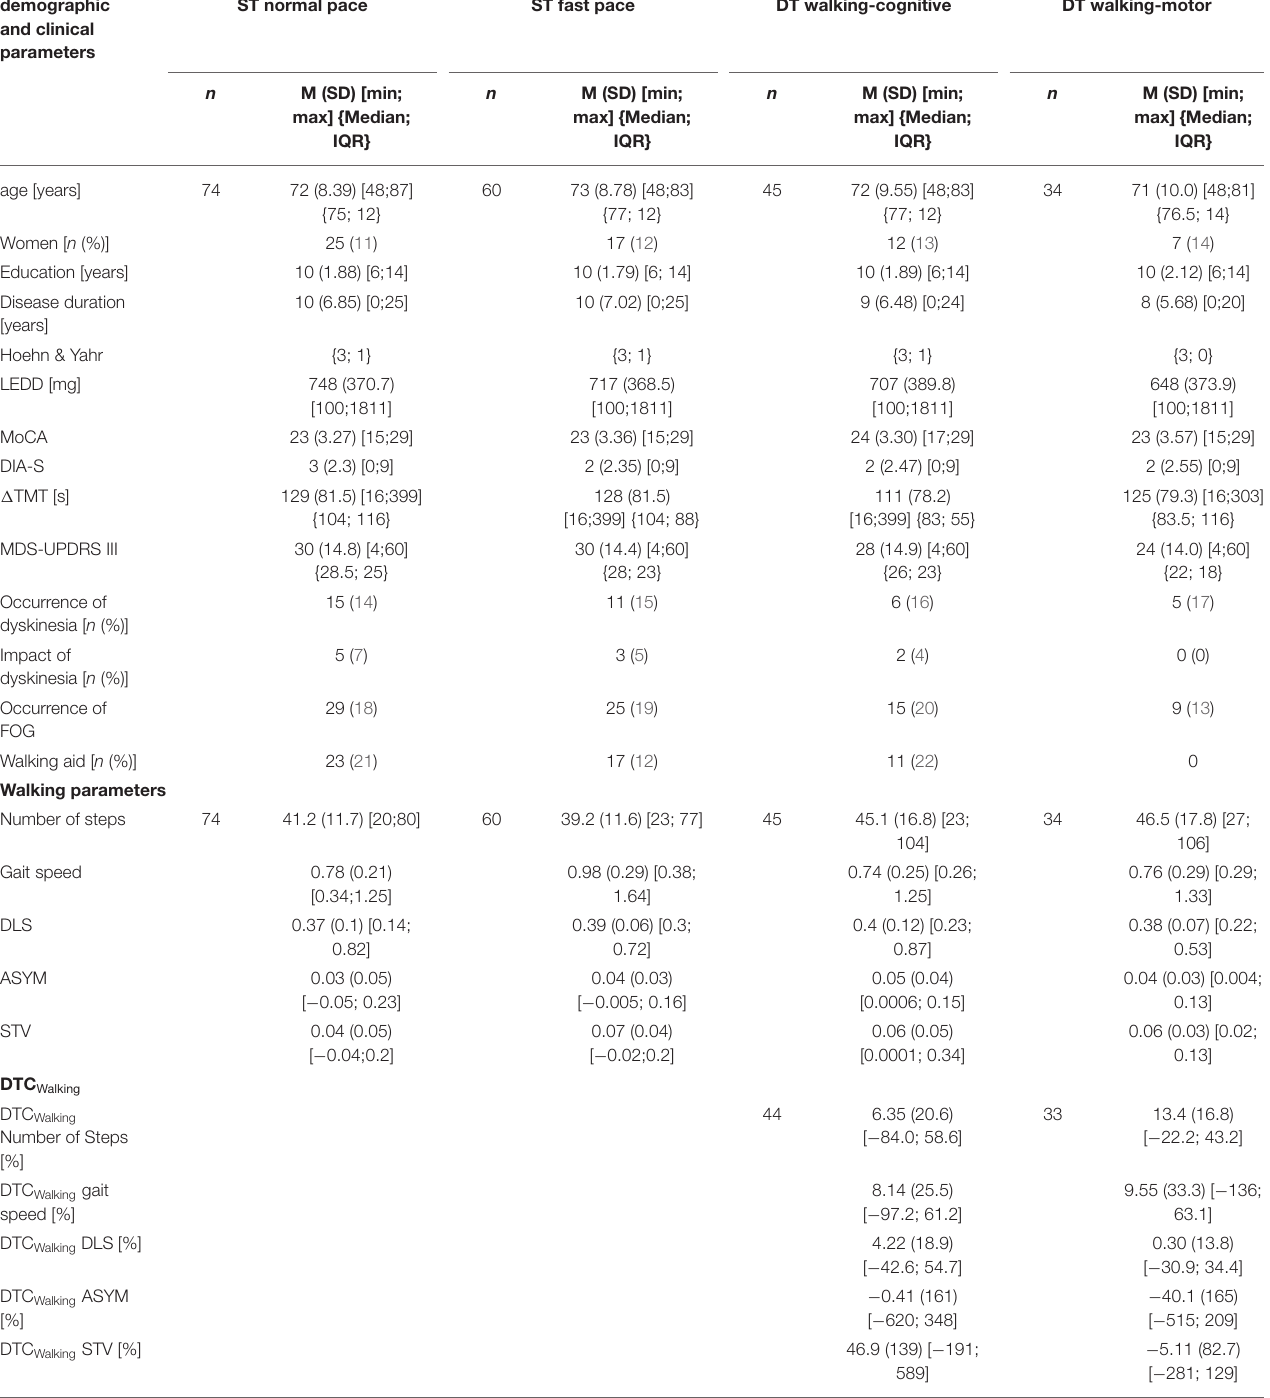
TABLE 1 | Descriptive characteristics of demographic, clinical, and walking parameters over all four walking conditions and of DTC Walking over both DT walking conditions. demographic and